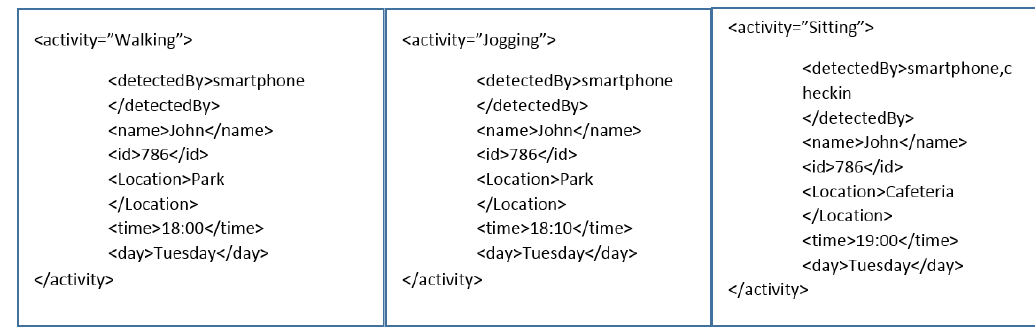
Figure 6. Context Information from activity